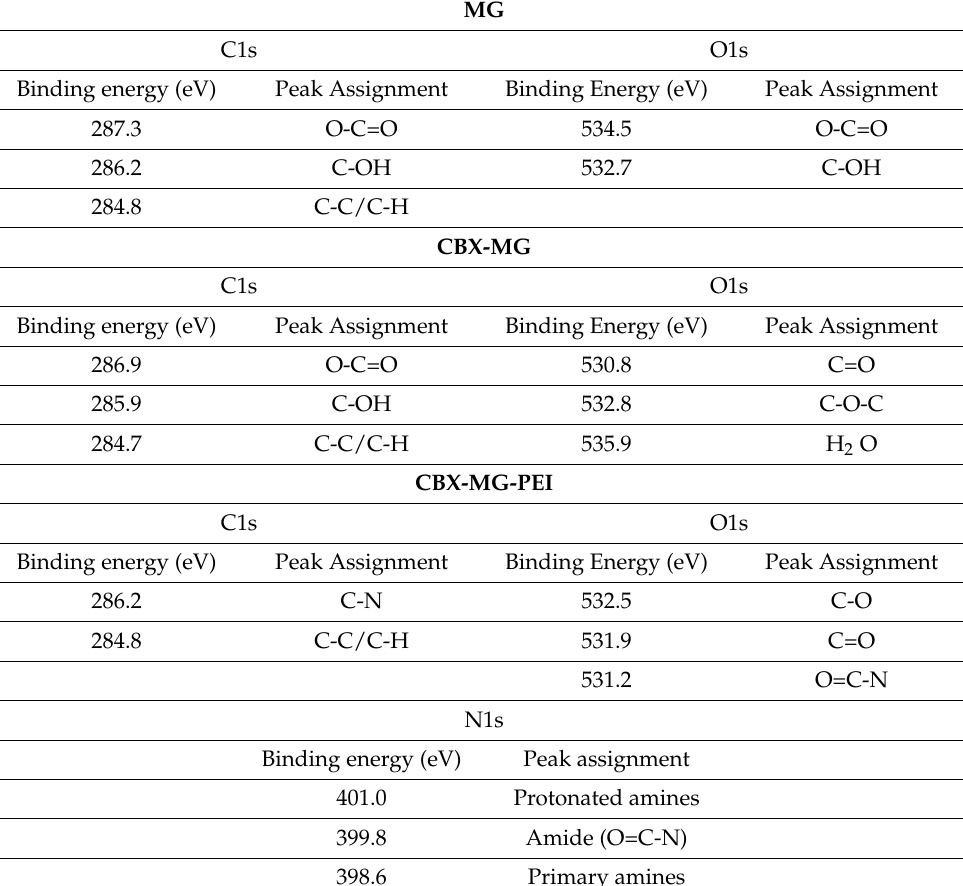
Table 2. XPS peak assignments of the MG, CBX-MG, and